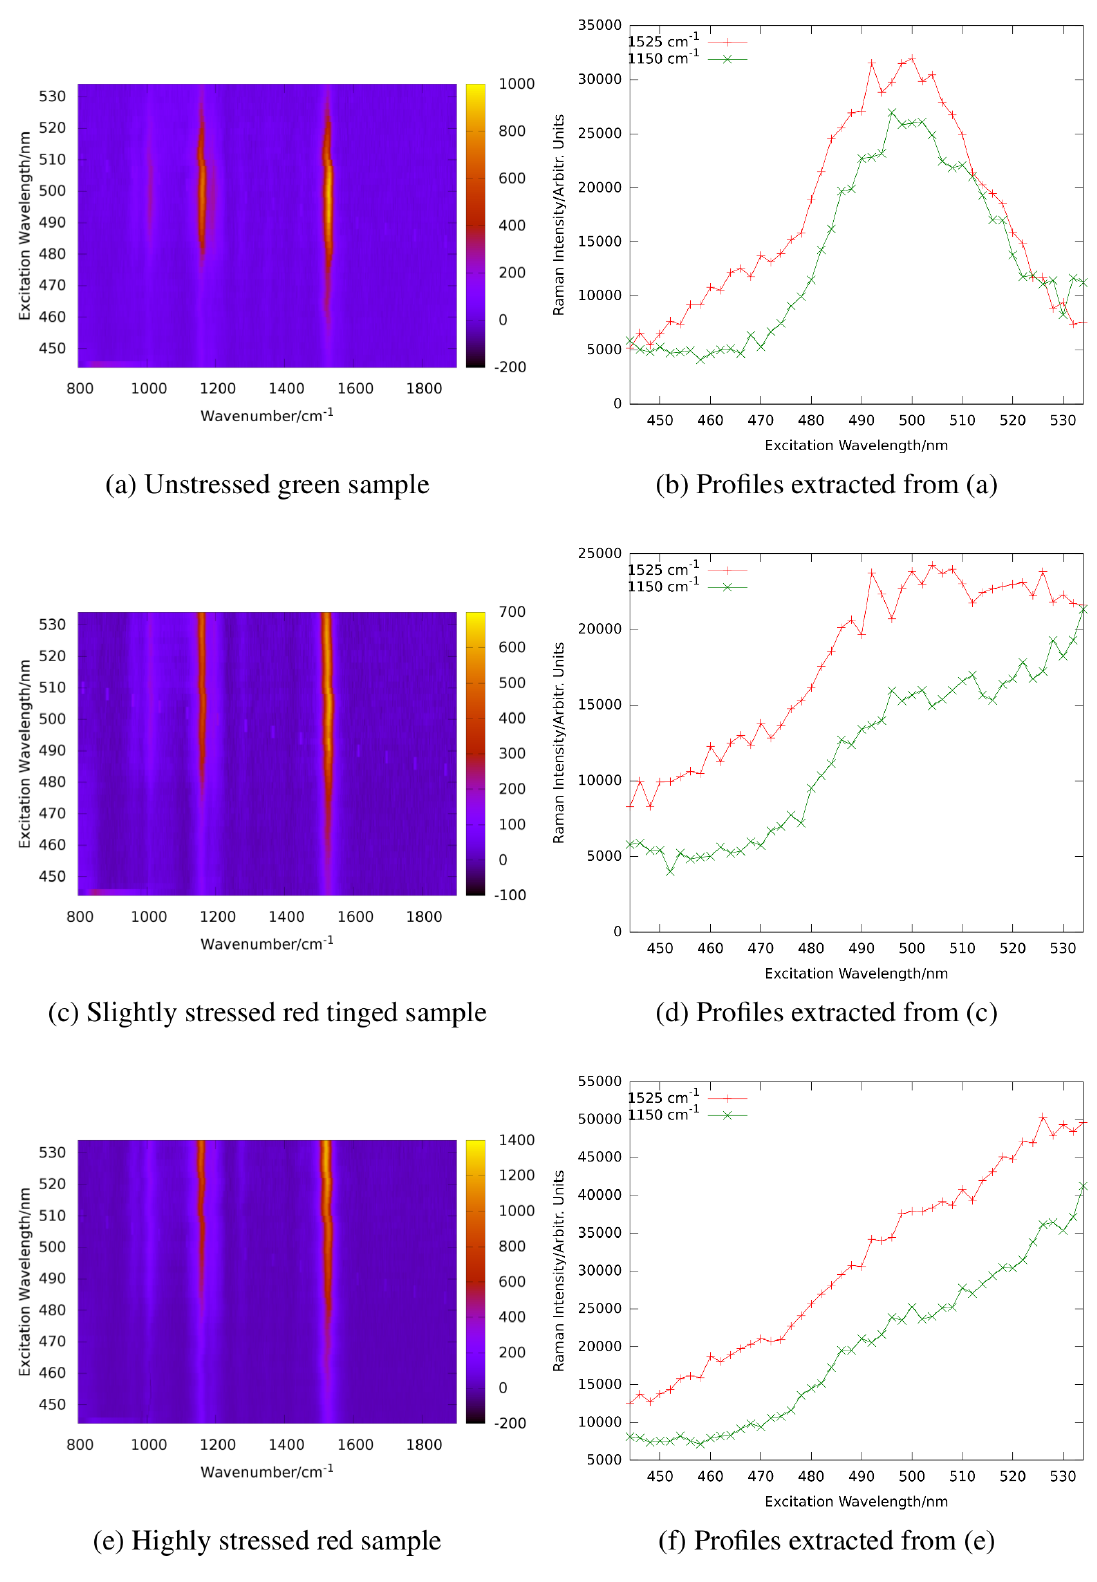
Figure 15. Resonance Raman maps ( left ) and corresponding resonance profiles ( right ) of haematococcus pluvialis at different stress levels: unstressed ( upper row), slightly stressed ( middle row) and strongly stressed ( bottom row) (reproduced with permission from